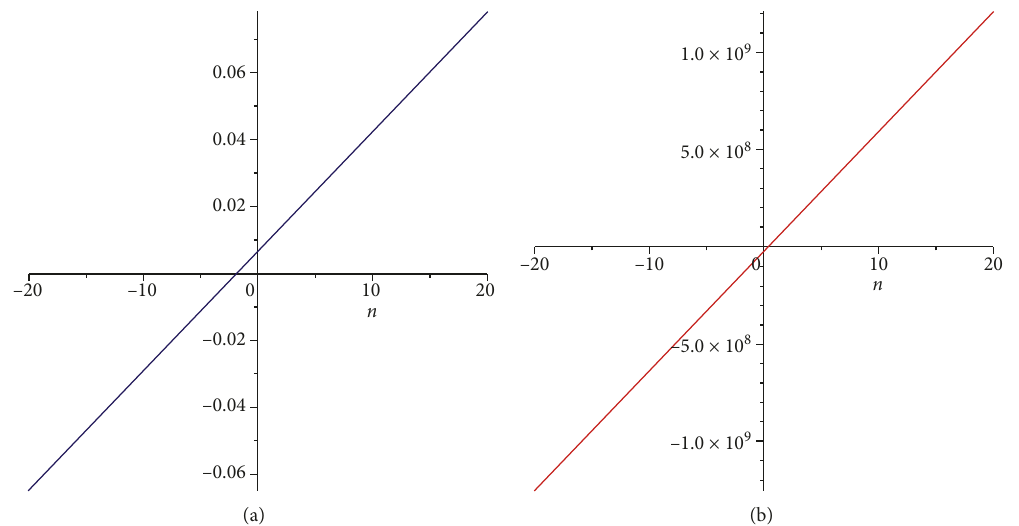
Figure 7: (a) The 2D plot of the Randi´c index for BR ( m,n ) . (b) The 2D plot of the inverse Randi´c index for BR ( m,n ) .